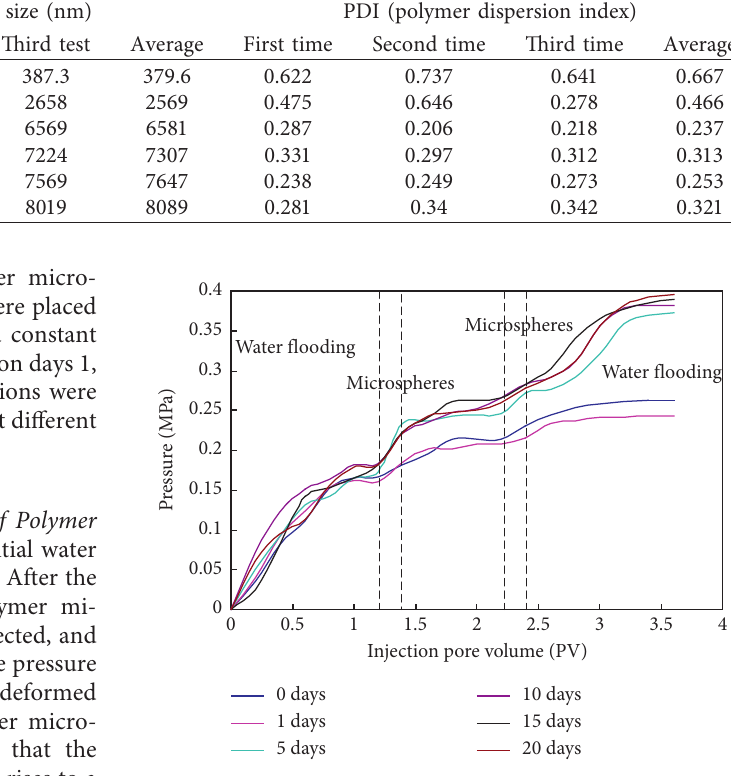
Figure 8: Plugging pressure curve of polymer microsphere